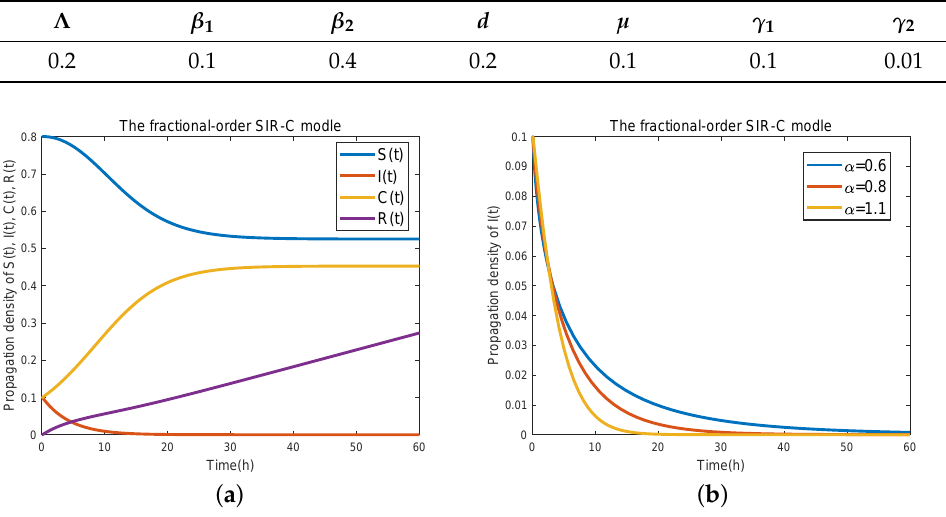
Figure 3. ( a ) Global stability of the boundary equilibrium point (BEP) E 1 = ( 0.525,0,0.45 ) , for system (7). ( b ) Consider the effect of different differential orders of α ∈ { 0.6,0.8,1.1 } on the spread of cyber rumors, for system